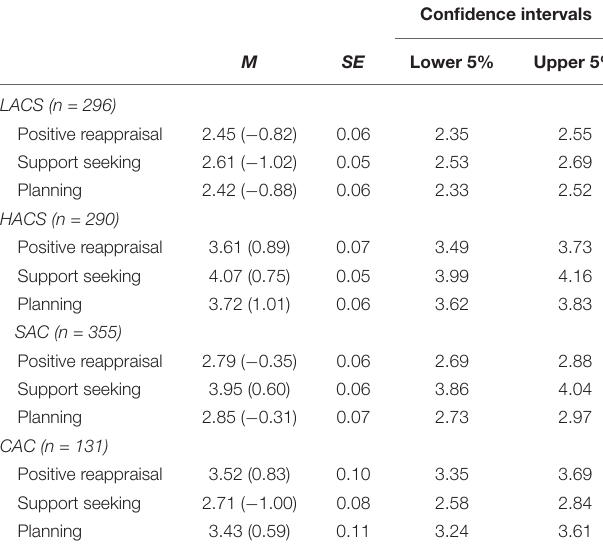
TABLE 4 | Description of latent profiles (means, standard errors, and confidence